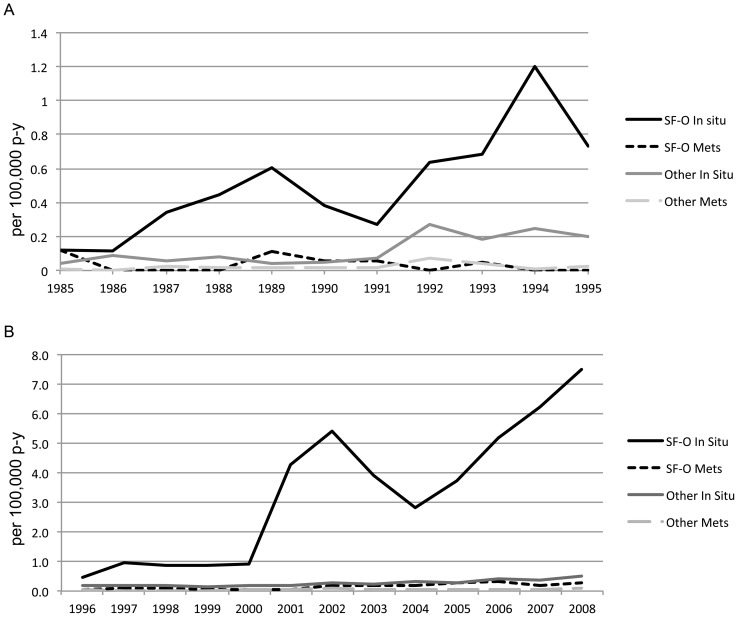
Incidence of in situ and metastatic squamous cell carcinoma of the anus, anal canal, and anorectum among men in San Francisco-Oakland (SF-O) compared to all other SEER sites.A. Pre-highly active antiretroviral therapy era (HAART); B. Post-HAART. X-axis. Year. Y-axis: per 100,000 person-years.